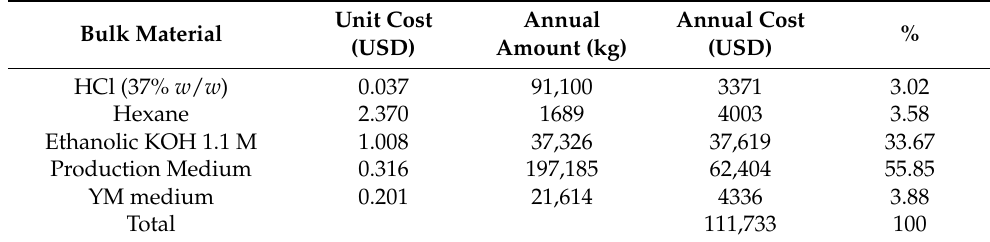
Table 8. Raw material cost breakdown for microbial oil and carotenoids production.